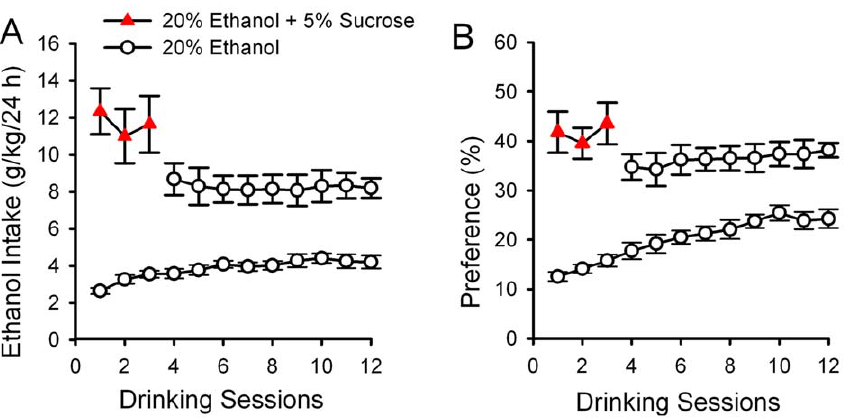
Figure 1. Sucrose induction induced excessive ethanol consumption and high preference in male Sprague-Dawley (SD) rats. The mean ( 6 S.E.M) of ethanol intake (g/kg/24 h) ( A ) and of ethanol preference ( B ) in rats under the intermittent access drinking procedure with 5% sucrose in the first three drinking sessions were much higher than those in rats under the same drinking procedure without sucrose induction (all p , 0.001). Two-way RM ANOVA followed by Tukey post hoc analysis, n=11 animals for 20% + 5% sucrose; n=22 animals for 20% ethanol.